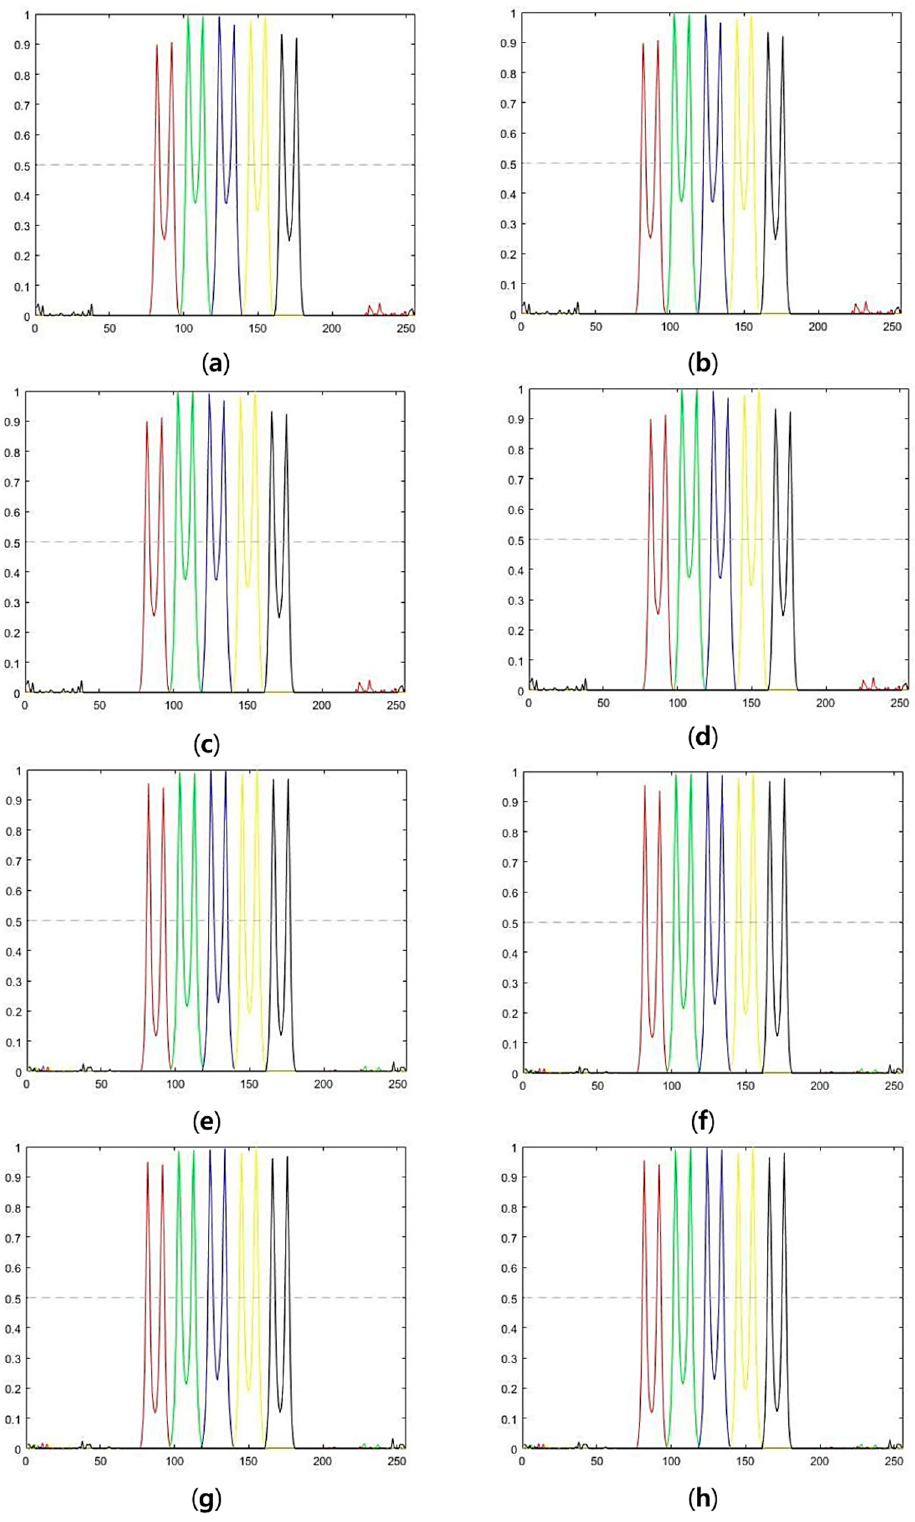
Figure 9. Intensity profiles of deconvolution results for 10 dB images: ( a ) Depth-invariant symmetric OSL algorithm, ( b ) depth-invariant symmetric GEM algorithm, ( c ) depth-variant symmetric OSL algorithm, ( d ) depth-variant symmetric GEM algorithm, ( e ) depth-variant symmetric OSL algorithm, ( f ) depth-variant asymmetric GEM algorithm, ( g ) depth-variant asymmetric OSL algorithm, and ( h ) depth-variant asymmetric GEM algorithm.